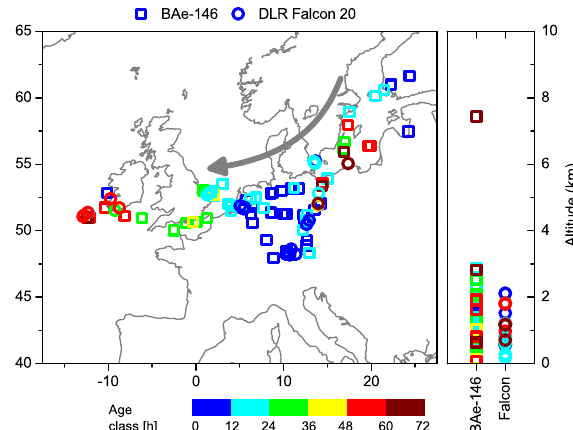
Fig. 7. Horizontal and vertical distribution of flight legs classified into different age classes using trajectory analysis. The arrow de- picts the main air mass transport direction during the anticyclonic conditions. For detailed information see